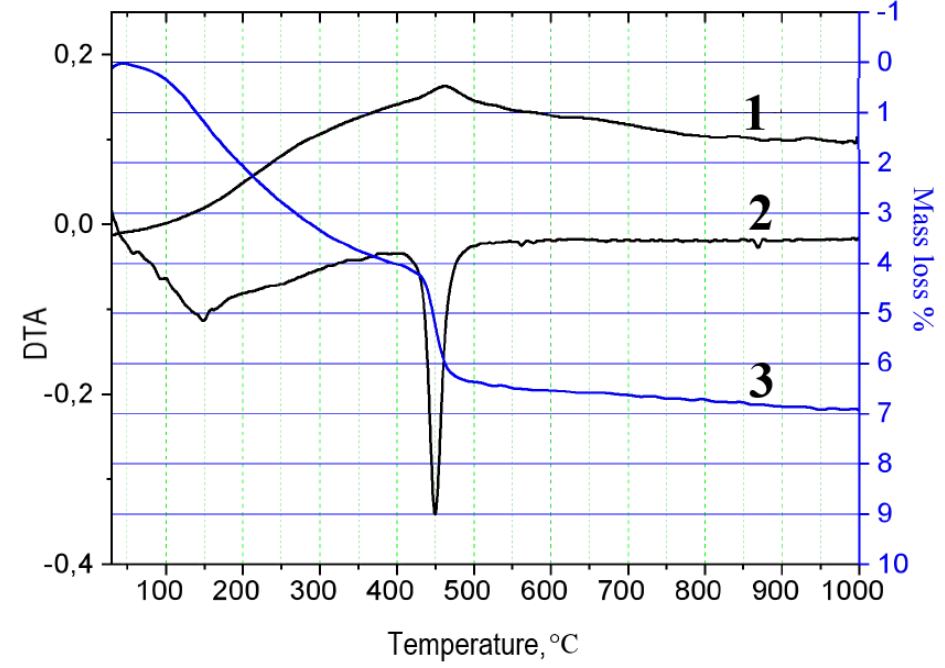
Figure 2. DTA–DTG curves obtained for LiNb 0,5 Та 0,5 O 3 powders, which underwent a high-energy ball milling process for 15 h at a rotation speed of 600 rpm (1—DTA; 2—DTG; 3—TG). At the same time, it is known that lithium carbonate decomposes above 800 °C [25]. Therefore, significant lowering of the temperature of this process is observed after milling the reaction mixture. In addition, the experimental value of mass loss in the temperature range 400–550 °C is about 20% of the theoretical value calculated by (1). The latter indi- cates that about 80% of lithium carbonate is decomposed at the stage of milling. Above 550 °C, the interaction of the formed lithium oxide with niobium (tantalum) oxides ac- cording to Reaction (2) occurs: Li 2 O + Nb 2 O 5 (Ta 2 O 5 ) = 2LiNb(Ta)O 3 . (2)